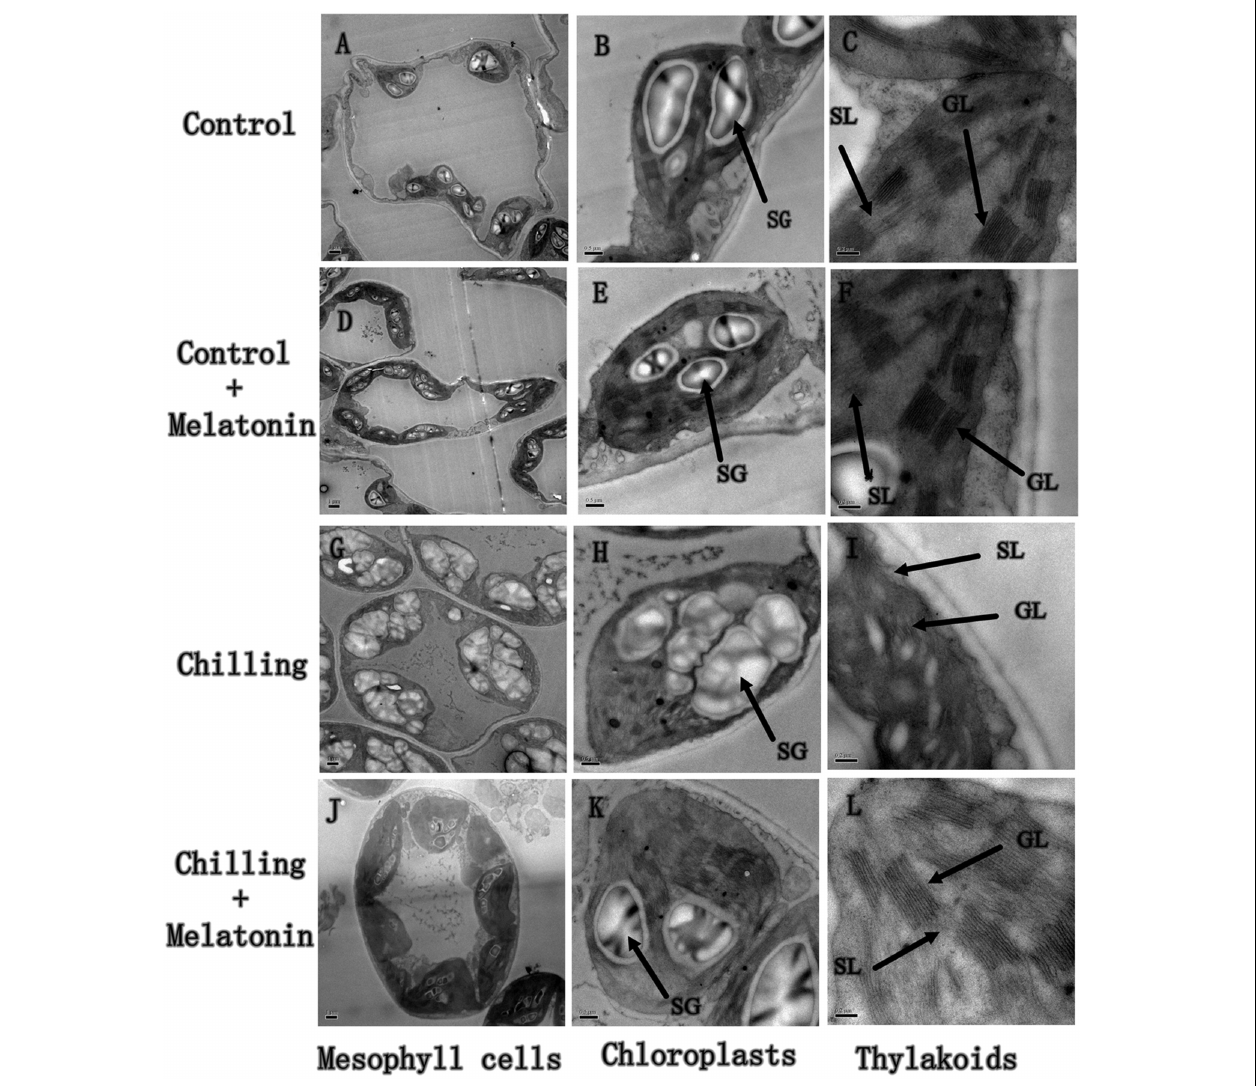
FIGURE 2 | Effects of exogenous melatonin on chloroplast structure under chilling stress. The second, fully expanded leaves were measured after 4 days of chilling. (A–C) Control (28/18 ◦ C); (D–F) Control + Melatonin (200 µ M melatonin, 28/18 ◦ C); (G–I) Chilling (15/8 ◦ C); (J–L) Chilling + Melatonin (200 µ M